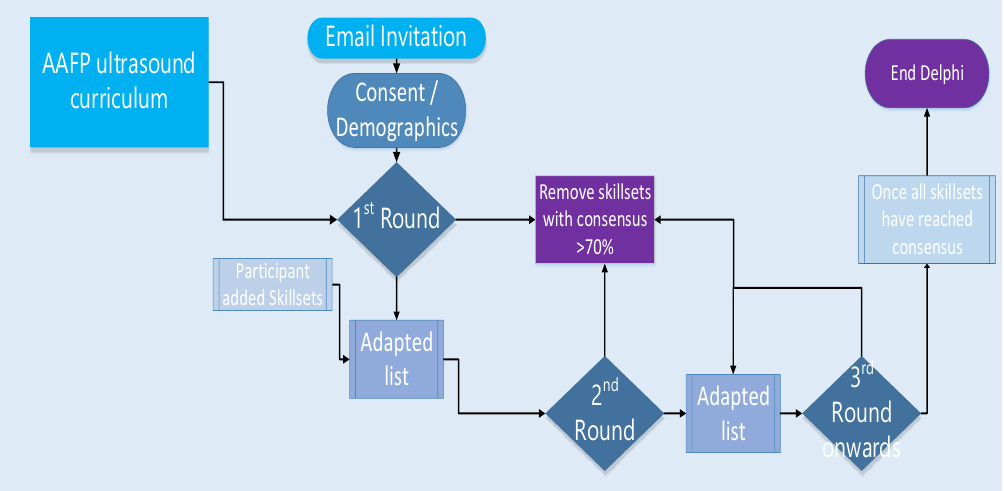
Figure 1. The proposed survey process.